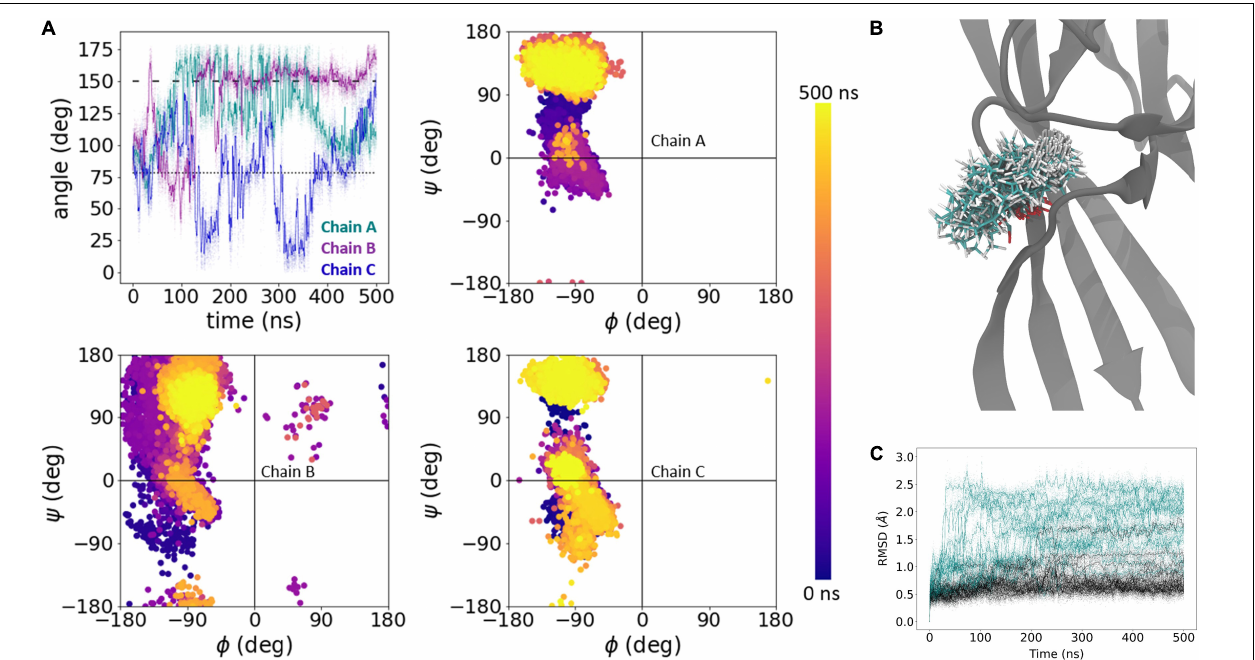
FIGURE 6 | Dynamics of Leu414 in N415G mutation. (A) Side chain bond angle (upper left) and phi/psi plots (upper right, lower) of Leu414 chains in N415G simulation, run 2. The dotted line illustrates the side chain angle of L414 in the desensitized state structure while the dashed line illustrates the side chain angle in the resting state structure. (B) 1000 snapshots from chain B, at regular intervals, from simulation in panel (A) . (C) Calculated RMSD of individual chains as a function of time for C α atoms of amino acid residues 409–420 of wildtype (black) and N415G (teal). Raw data is plotted in the background as transparent dots, smoothed data is plotted as a solid